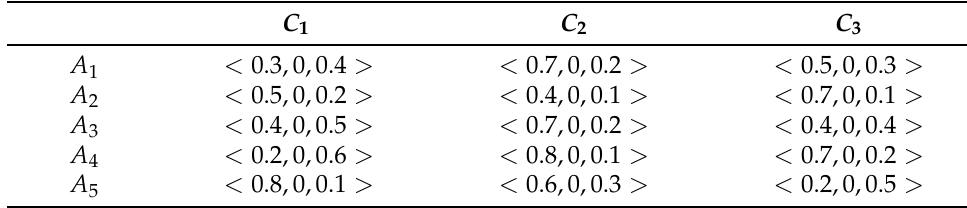
Table 10. T-spherical fuzzy decision